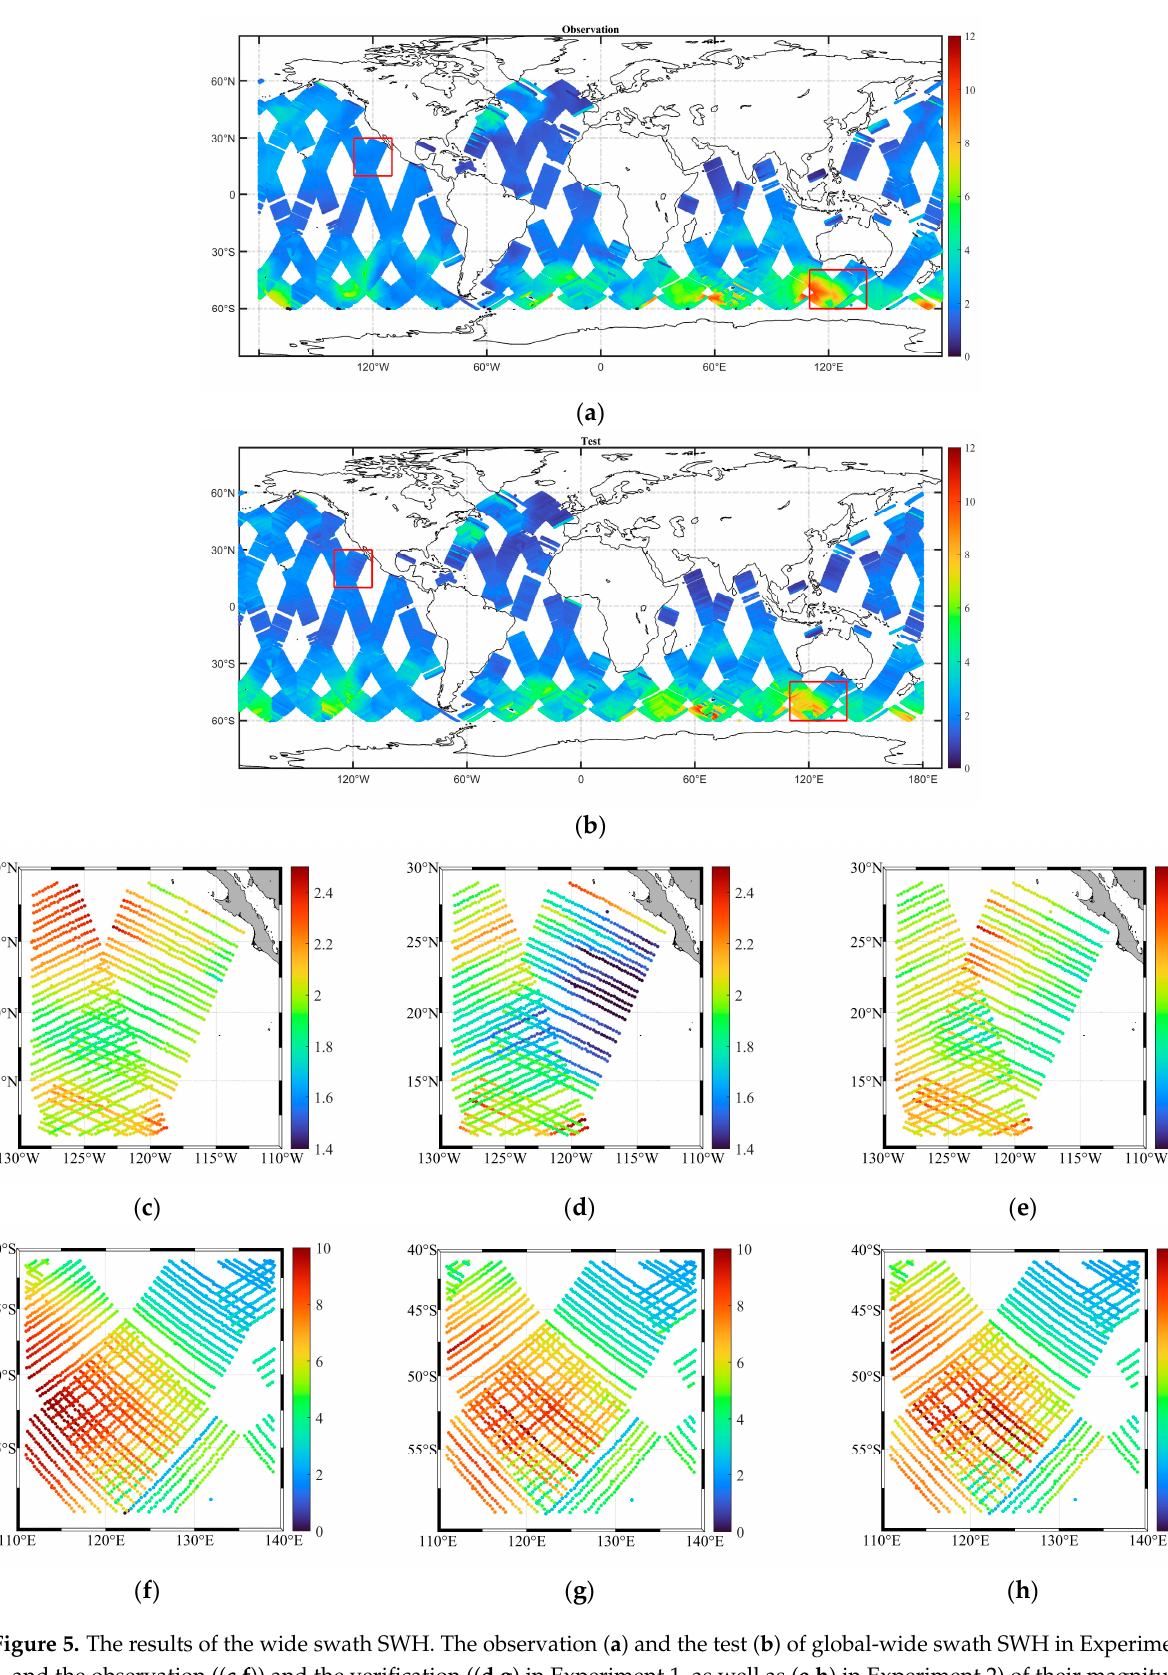
Figure 5. The results of the wide swath SWH. The observation ( a ) and the test ( b ) of global-wide swath SWH in Experiment 1, and the observation (( c , f )) and the verification (( d , g ) in Experiment 1, as well as ( e , h ) in Experiment 2) of their magnitude plots in the northwestern area and the southeastern area (the red boxes in ( a , b )), respectively.